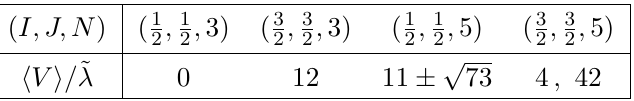
Table 9 . The eigenvalues of V for the excited states with N X = 0, N w = 3 and N (cid:22) w = 0, and those with N w = 4 and N (cid:22) w = 1 in the cases of I = J = 1 = 2 and I = J = 3 = 2. Here, N is the total number of the excitations, N = N w + N (cid:22) w